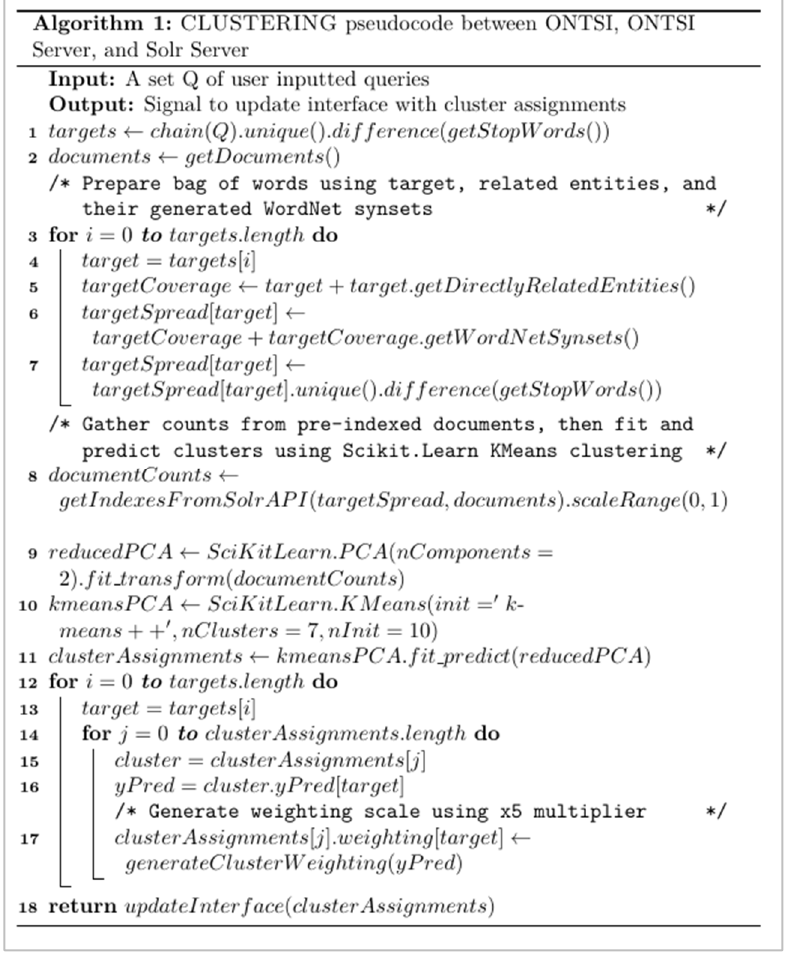
Figure 6. Pseudocode of clustering spanning the workflow of ONTSI (front end), ONTSI server, and Solr server.